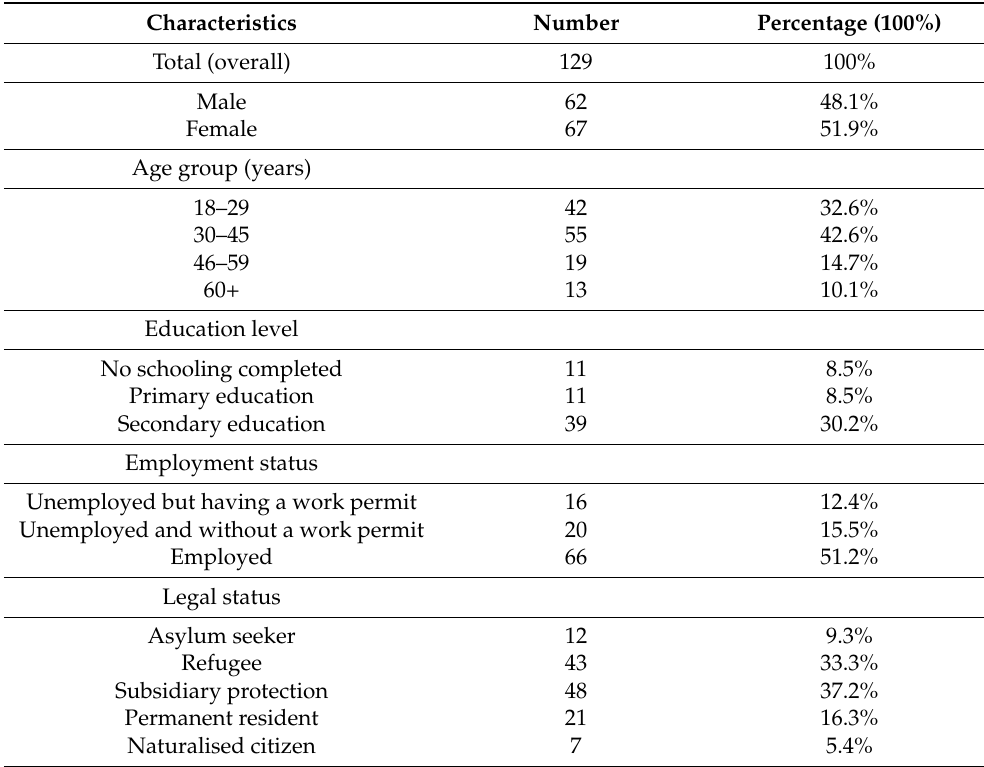
Table 1. Participants’ demographic characteristics.